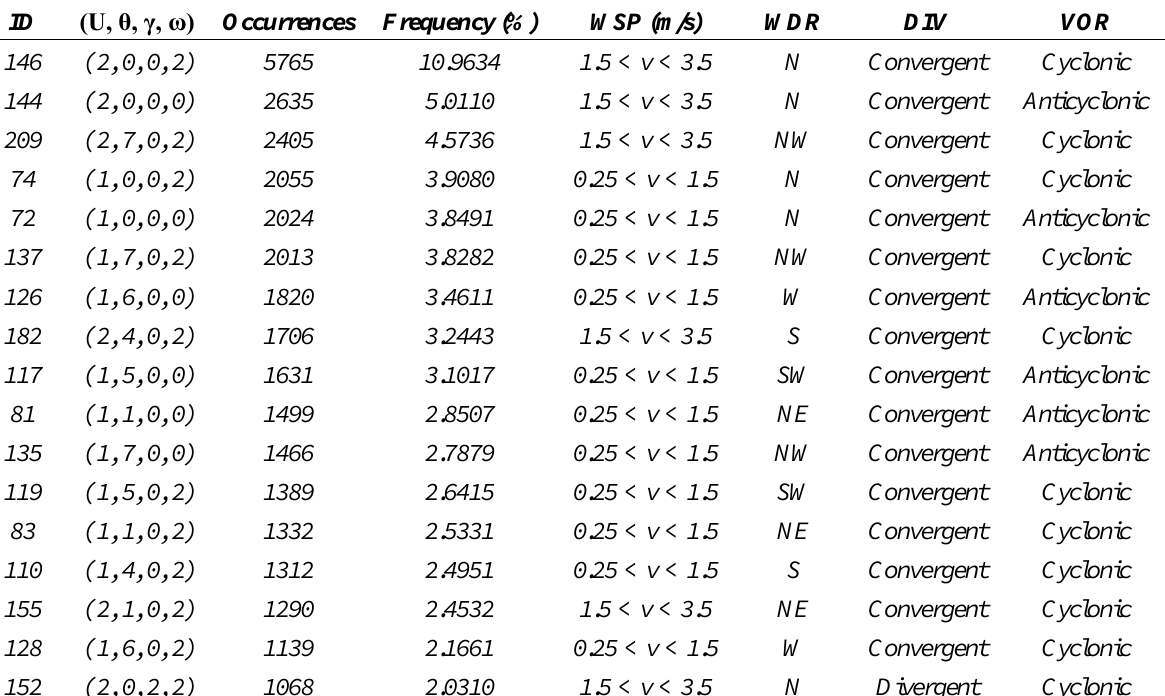
Figure 6. Distribution of the occurrence frequencies of the discrete wind states. Table 6. Mexico City discrete wind states with the highest occurrence frequencies. Period: